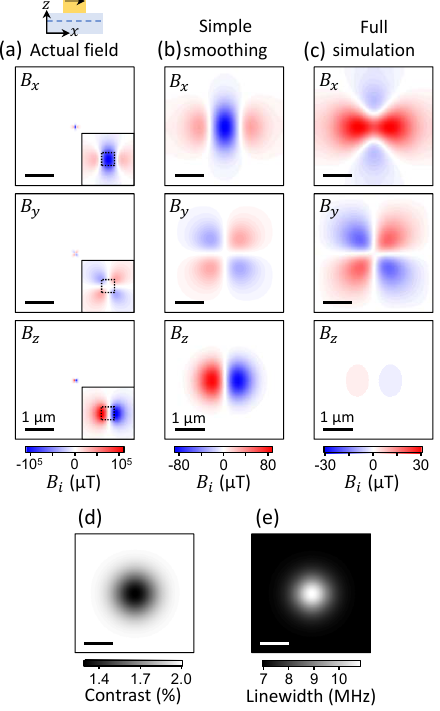
Figure 4. ( a ) Magnetic field calculated at a stand-off d = 20 nm for a 50 × 50 × 50 nm 3 particle magnetised along x with M s = 10 6 A/m (see schematic). Inset: magnified view near the particle, whose physical footprint (50 × 50 nm 2 ) is indicated by a dashed box. ( b ) Apparent magnetic field obtained by convolving the actual field ( a ) with a 2D Gaussian function of 1 µ m FWHM. Notice the three orders of magnitude weaker field values in ( b ) compared with ( a ). ( c ) Apparent magnetic field obtained by simulating the full measurement process (see details in text). ( d , e ) Maps of the contrast ( d ) and linewidth ( e ) of the lowest-frequency resonance in the simulated ODMR